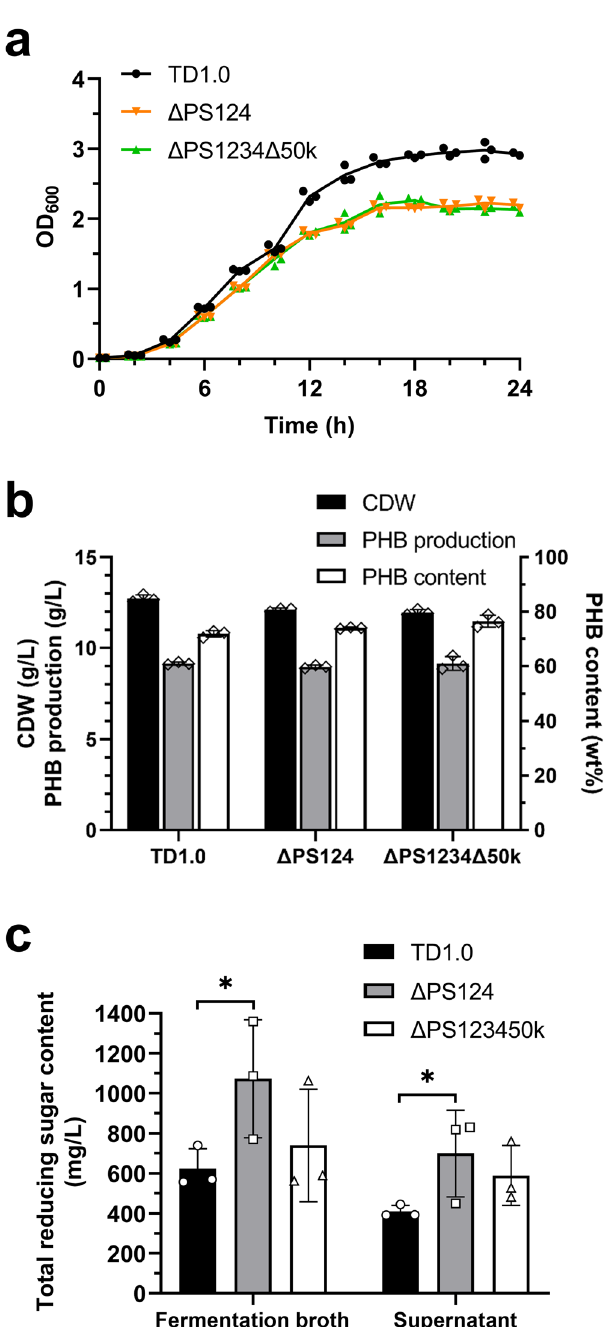
Fig. 7 Comparison of growth and fermentation of TD1.0, Δ PS124 and Δ PS1234 Δ 50k. a Growth curves. The strains were cultured in LB60 medium and growth was monitored at OD 600 . b Shake- fl ask experiment of TD1.0, Δ PS124 and Δ PS1234 Δ 50k. Strains were cultured in 60 MMG medium at 37 °C for 36 h. c Total reducing sugar content after shake- fl ask experiment for 36 h. Data are shown from three biological replicates. Error bars are SD ( n = 3 unpaired t test, * P < 0.05). TD1.0, H . bluephagenesis TD1.0; Δ PS124, H . bluephagenesis TD1.0 with deletion of PS1, PS2, and PS4 gene clusters; Δ PS1234 Δ 50k, H . bluephagenesis TD1.0 with deletion of PS1, PS2, PS4, and PS3 gene clusters and fl agellar gene 2500 V) were selected to test the best fi eld strength. A total of 500 ng of plasmid pSEVA341 was transformed into the tested strains with a cell number of 1 – 2 × 10 9 by electrotransformation method. As shown in Fig. 8 and Table 1, the wild-type H.